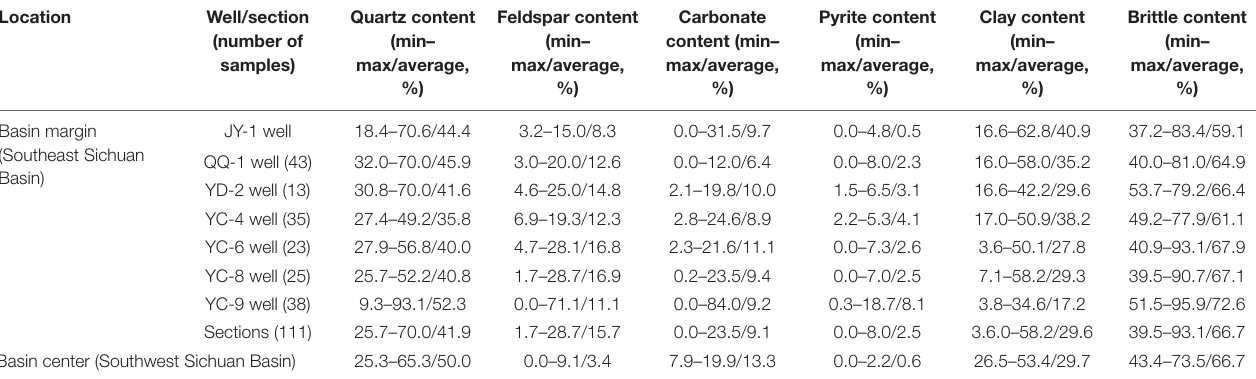
TABLE 2 | Mineral compositions of the organic-rich shale in the Sichuan Basin